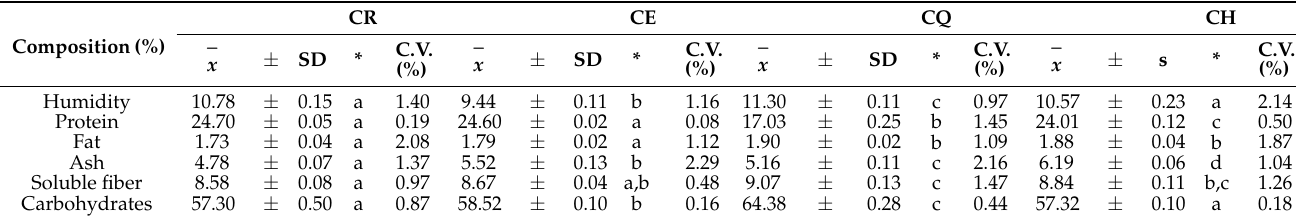
Table 3. Composition of dehydrated